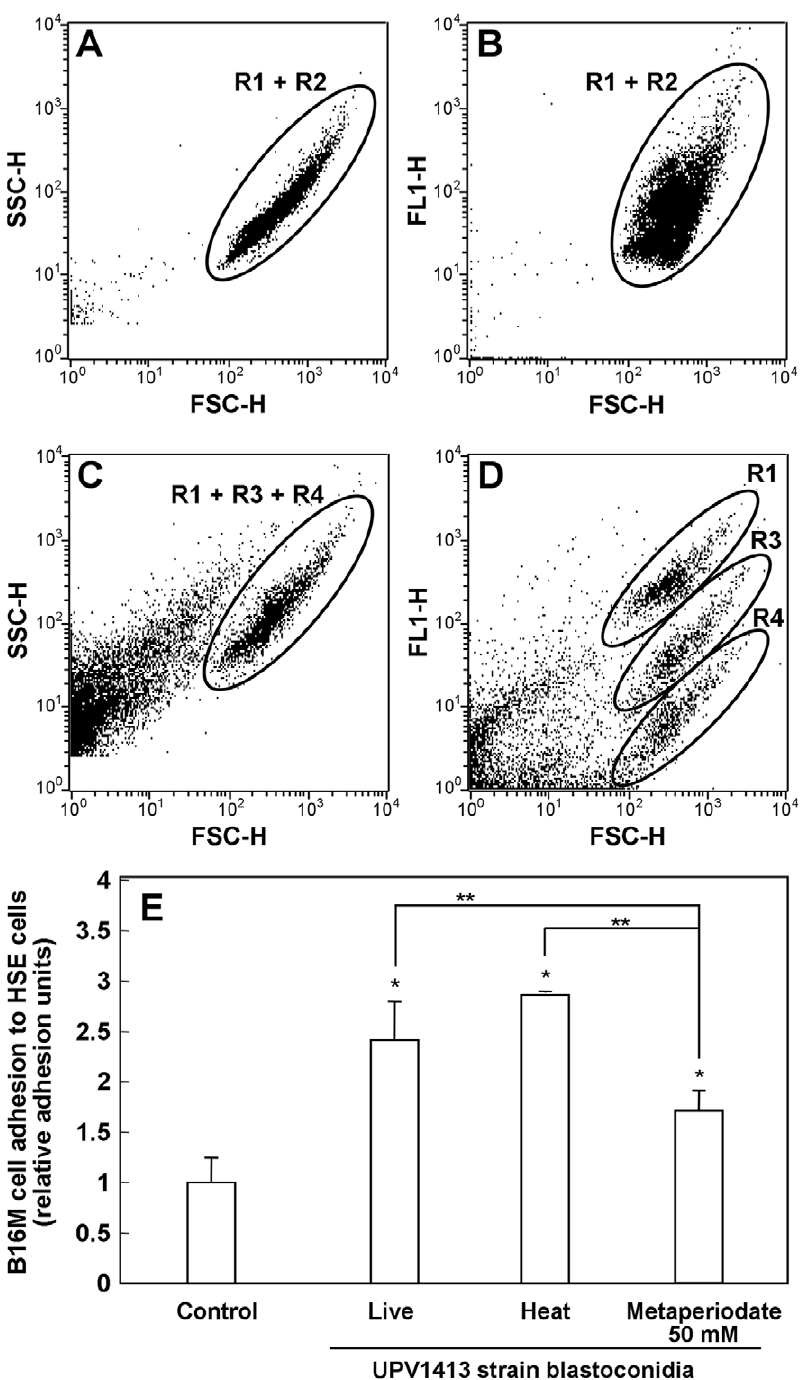
Figure 3. Results obtained from the killing treatments. (A–D) Effect of heat and metaperiodate treatments on Candida albicans cell surface studied by incubation with Con A-FITC followed by flow cytometry: cell complexity (side scatter, SSC), cell size (Forward Scatter, FSC), and fluorescence (FL1). R1: live cells. R2: cells killed with heat. R3: cells killed with a 20 mM metaperiodate. R4: cells killed with 50 mM metaperiodate. (E) Effect of heat- and sodium metaperiodate (50 mM)-treated C. albicans blastoconidia on the increase of B16 melanoma (B16M) cell adhesion to HSE. The results shown correspond to the mean 6 SD of three independent experiments. Statistically significant differences with respect to the control or between cell conditions are indicated by one and two asterisks (**) (p , 0.05), respectively.